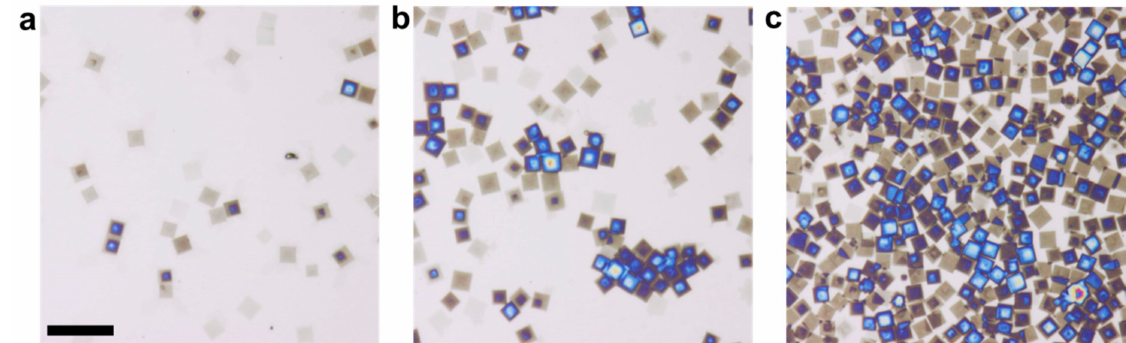
Figure 2. Optical micrographs demonstrating the influence of the concentration ( c ) of PS- b -PEO in toluene on the number ( N ) of resulting platelet-like crystals on silicon wafers. c varied from ( a ) 5 mg/mL, ( b ) 10 mg/mL, and ( c ) 20 mg/mL. The polymer was crystallized at T C = 20 ◦ C for 24 h after seeding at T SS = 40 ◦ C for 30 min. The scale bar represents 15 µ